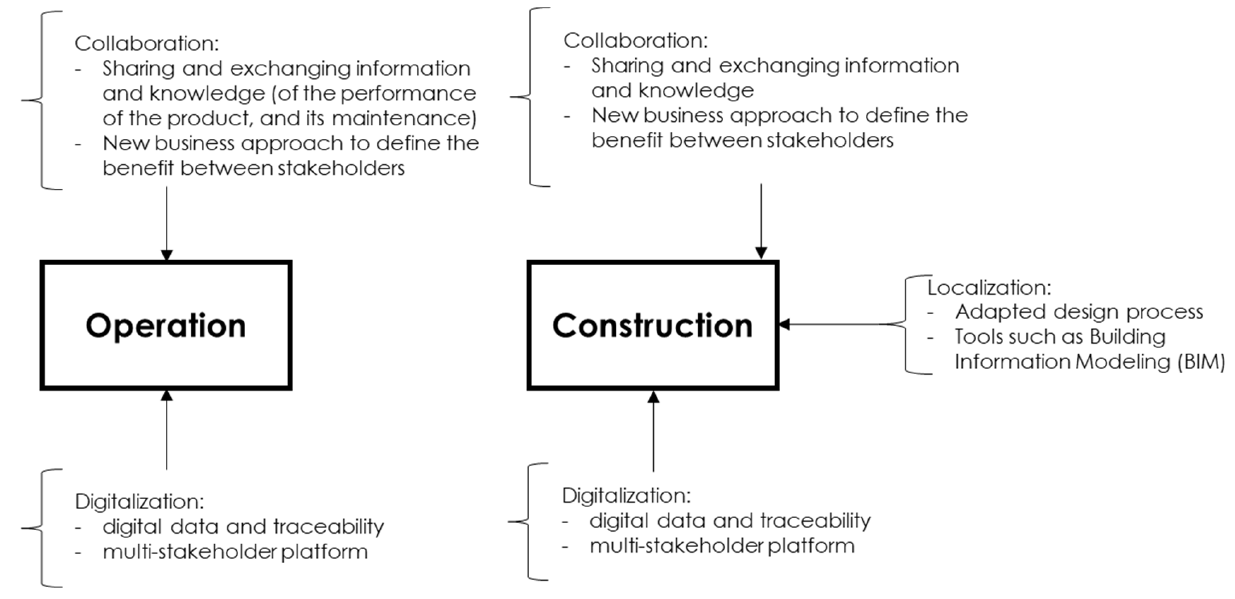
Figure 3. Practical implications taken from the proposed integrated framework in the most two critical sectors.